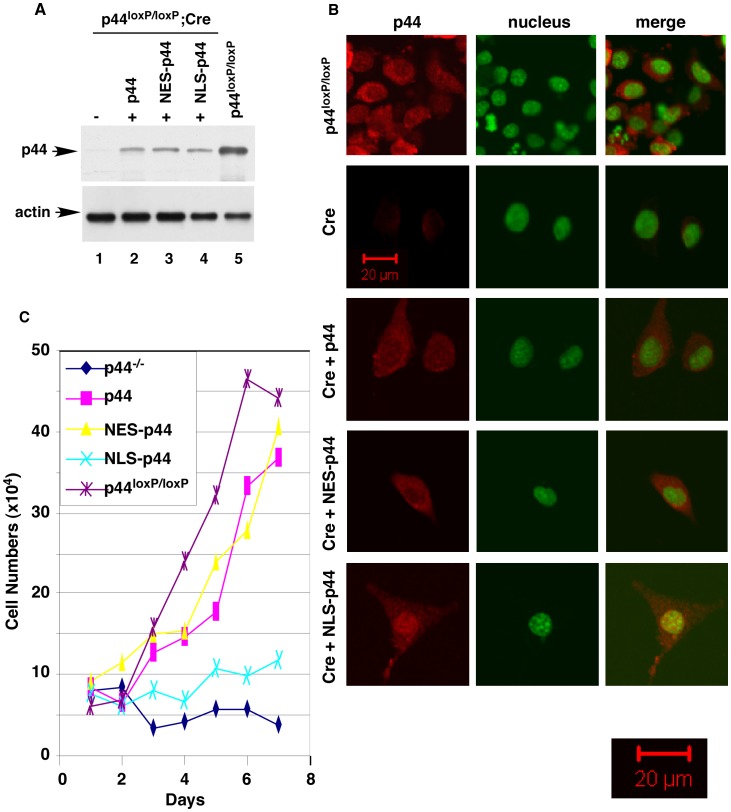
Cytoplasmic p44 is essential for growth of prostate epithelial cells.(A) Expression of p44, NES-p44, or NLS-p44 in the p44-null prostate epithelial cells. Western blot analysis of whole cell lysates (10 µg) made from p44-null prostate epithelial cells infected with control lentivirus (lane 1) or lentivirus expressing p44 (lane 2), NES-p44 (lane 3), or NLS-p44 (lane 4), as indicated. The p44 wild-type (p44loxP/loxp) epithelial cells infected with control lentivirus were used as the control (lane 5). (B) The subcellular localization of p44, NES-p44, and NLS-p44 in prostate epithelial cells. Immunostaining of p44 in p44 wild-type (p44loxP/loxp) epithelial cells (top panels), in p44-null prostate epithelial cells infected with control lentivirus (2nd panel) or lentivirus expressing p44 (3rd panel), NES-p44 (4th panel), or NLS-p44 (bottom panel), as indicated. P44 and the nucleus were stained in red and green, respectively. The left pictures are a merger of p44 and nuclear staining. (C) Cytoplasmic p44 fully restored growth arrest of prostate epithelial cells induced by loss of p44. Growth curves of p44-null prostate epithelial cells infected with control lentivirus or lentivirus expressing p44, NES-p44, or NLS-p44. One-way ANOVA analysis: F = 43.00, p<0.0001, R square = 0.9485. The p value of unpaired Student’s t-Test of data between p44loxP/loxP and NES-p44, p44, or p44−/− epithelial cells are 0.3352, 0.2873, or 0.0003.